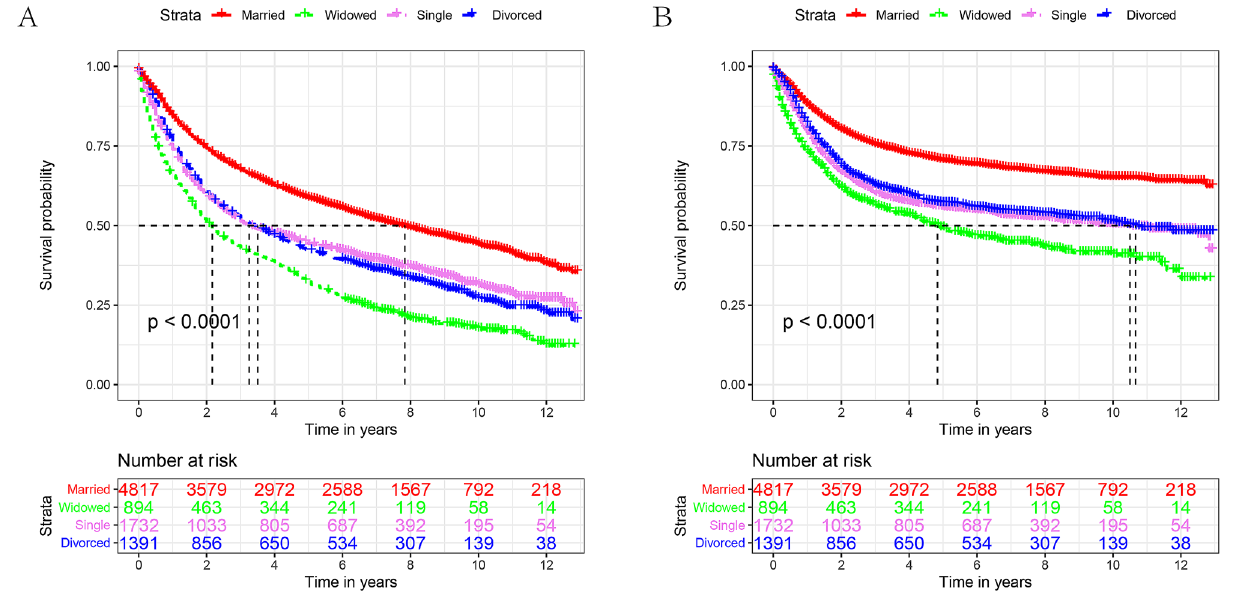
Figure 2. Kaplan–Meier survival curves for OS (A) and CSS (B) in different marital statuses. (OS: overall survival, CSS: cause-specific